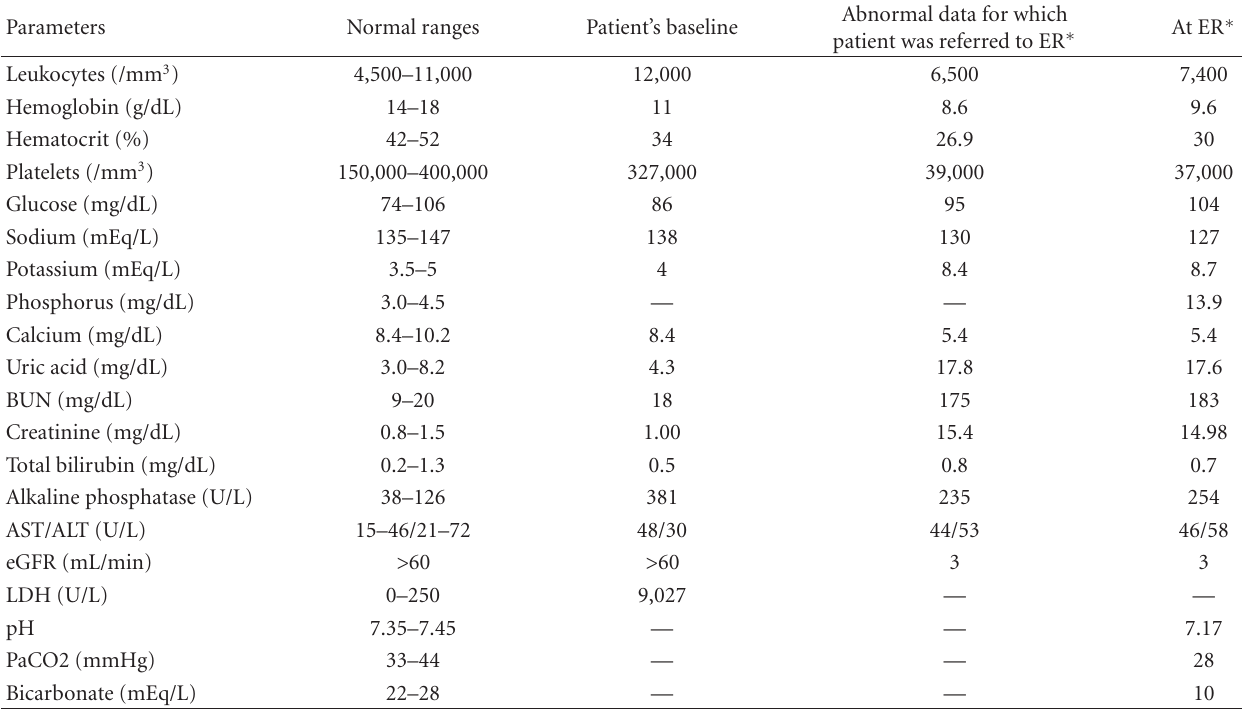
Table 2: Laboratory values before and after